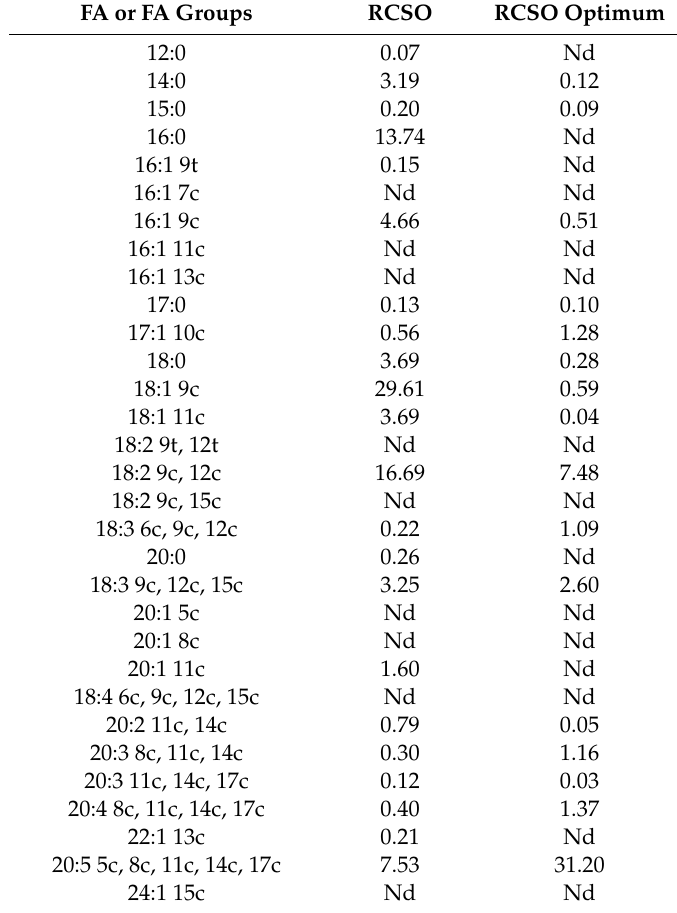
Table 1. Composition of fatty acids in (RCSO) and the optimized concentrate from RCSO (g / 100 g total FA)